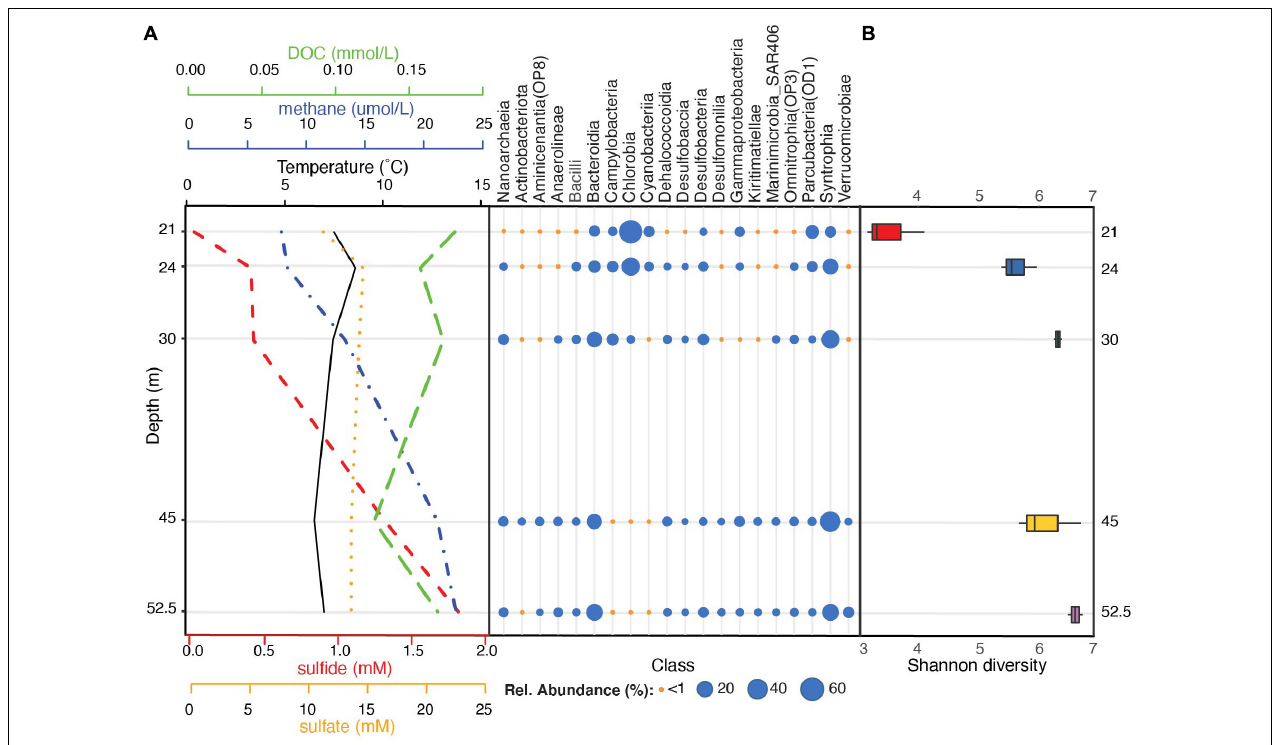
FIGURE 2 | Stratification of bacterial communities below the FGL chemocline. (A) Taxonomic profiles of the mean relative abundances of bacterial classes (SILVA v.138 taxonomy) for each sampled depth ( y -axis), alongside sulfide, sulfate, DOC, methane, and temperature profiles. Bacterial classes with at least one depth with > 1% mean relative abundance across samples are plotted. Temperature and methane concentrations were measured during sampling on August 14, 2013 while sulfide, sulfate, and DOC profiles were collected on July 2013 by Havig et al. (2015) (see Supplementary Table 1 for values). (B) Microbial community α -diversity (Shannon diversity) at each sampled